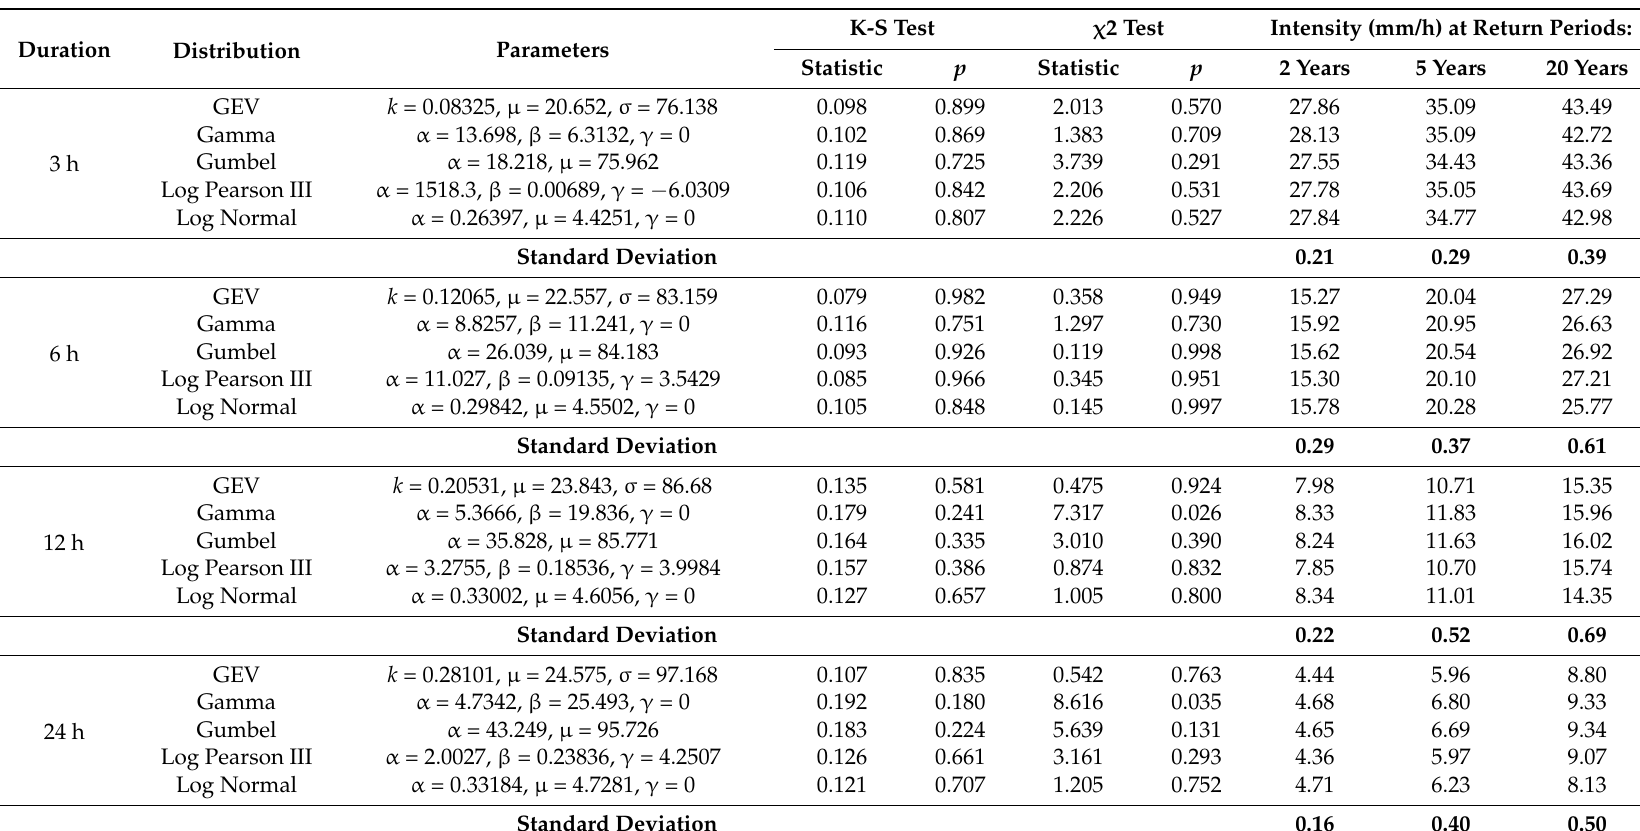
Table 3. Goodness of Fit between different distributions for annual maximum precipitation (1981–2010), showing parameters, Kolgomorov-Smirnov (K-S) test and Chi-squared ( χ 2) test statistics and p -values, and intensities at different return periods for each distribution and different